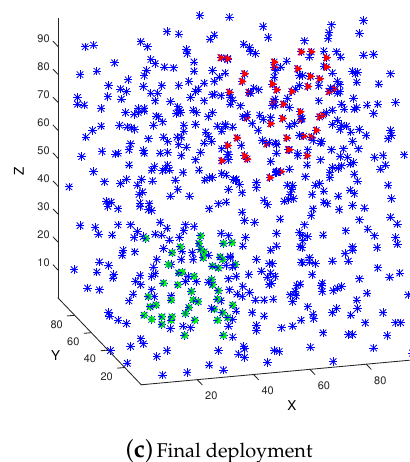
Figure 7. The deployment of 600 sensors in the 3D underwater area. ( a ) Initial deployment; ( b ) The first deployment round of k -ERVFA; ( c ) Final